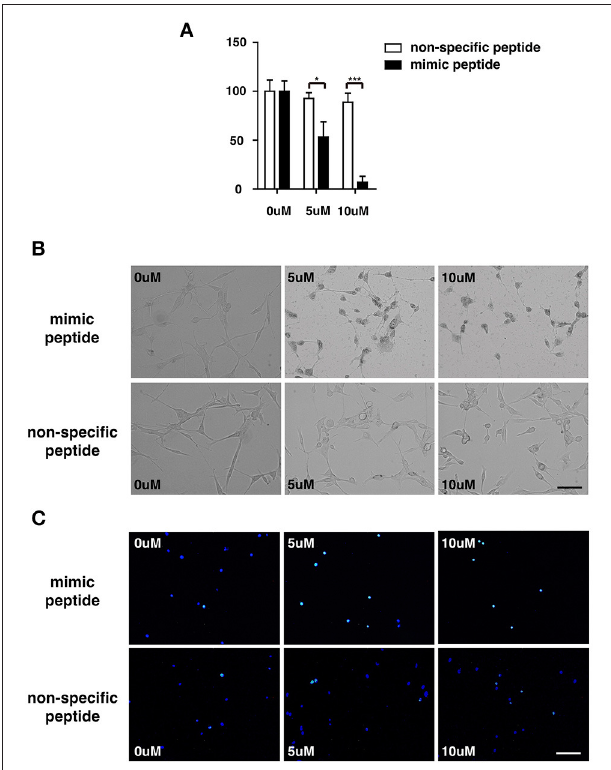
FIGURE 5 | U87 cells were treated with a synthetic peptide derived from ZCP. (A) Effect of the synthetic peptide on the viability of U87 cells is shown. U87 cells were exposed to different concentrations (0, 5, or 10 µ M) of the synthetic peptide for 4 h and cell viability was determined with the CCK-8 assay. Representative result is shown as the mean ± SD of triplicate wells from one of three independent experiments. (B) Morphology of U87 cells after incubation for 0, 6, or 12 h at 37 ◦ C with various peptide concentrations (0, 5, or 10 µ M). (C) Fluorescent signals for TUNEL staining (green) and DAPI (blue) in U87 cells treated with 0, 5, or 10 µ M ZCP peptide for 4 h at 37 ◦ C. Bars: 100 µ m. SD, standard deviation. * P < 0.05; *** P <